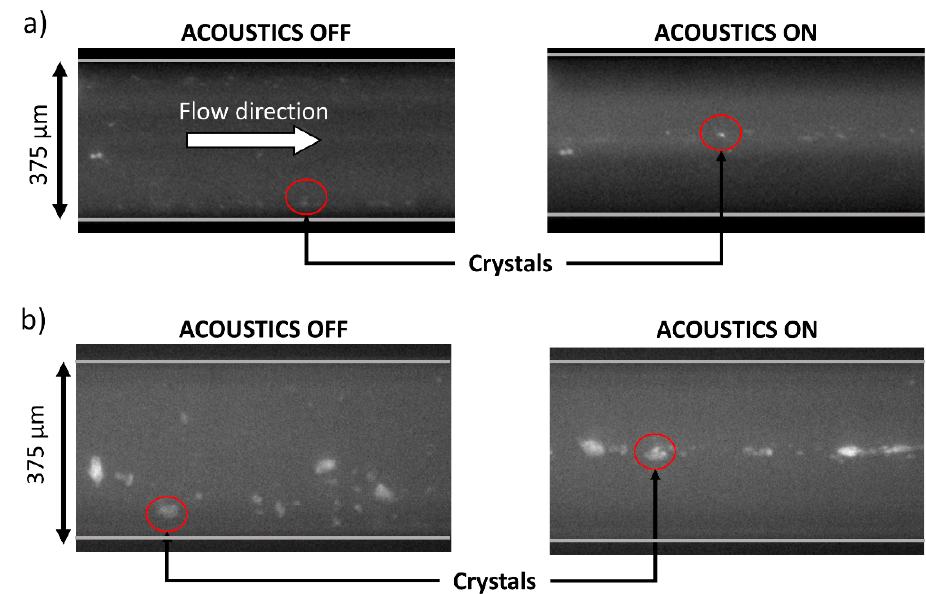
Figure 2. ( a ) Focusing of miconazole nitrate crystals (15 ± 3 µ m). Upon activation of the acoustic field, crystals are focused in the center of the microfluidic channel. Time needed to focus is 1.28 seconds at a driving voltage of 10 V p-p . ( b ) Focusing of lysozyme microcrystals (30 ± 13 µ m) in the center of the channel, the time needed to focus is 1.22 seconds at a driving voltage of 7 V p-p .